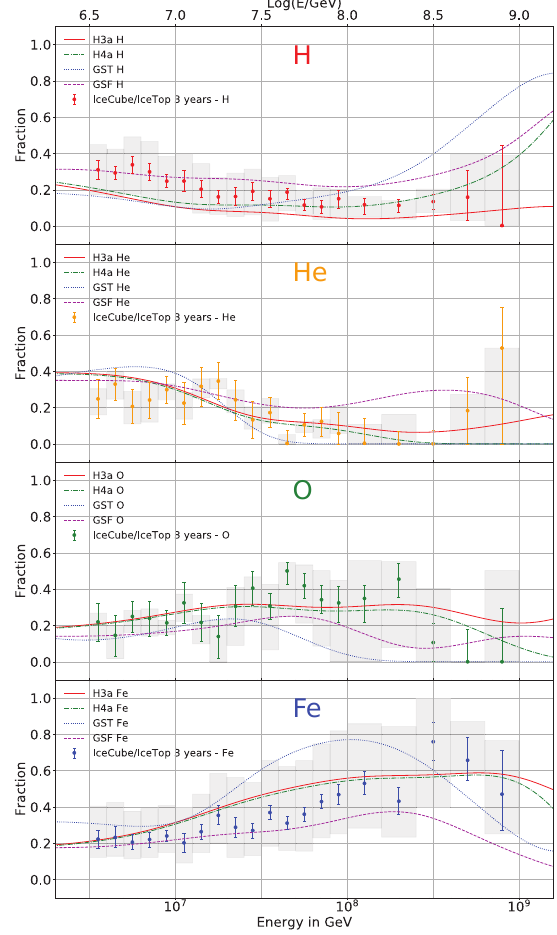
Figure 6: Fractions for the four elementary mass groups (H, He, O and Fe) [5] including the total detector system- atic compared with various cosmic ray models (H3a and H4a [6]) and phenomenological experimental fits (GST [7] and GSF [8]). As a hadronic interaction model, Sibyll2.1 [4] is used in the simulated